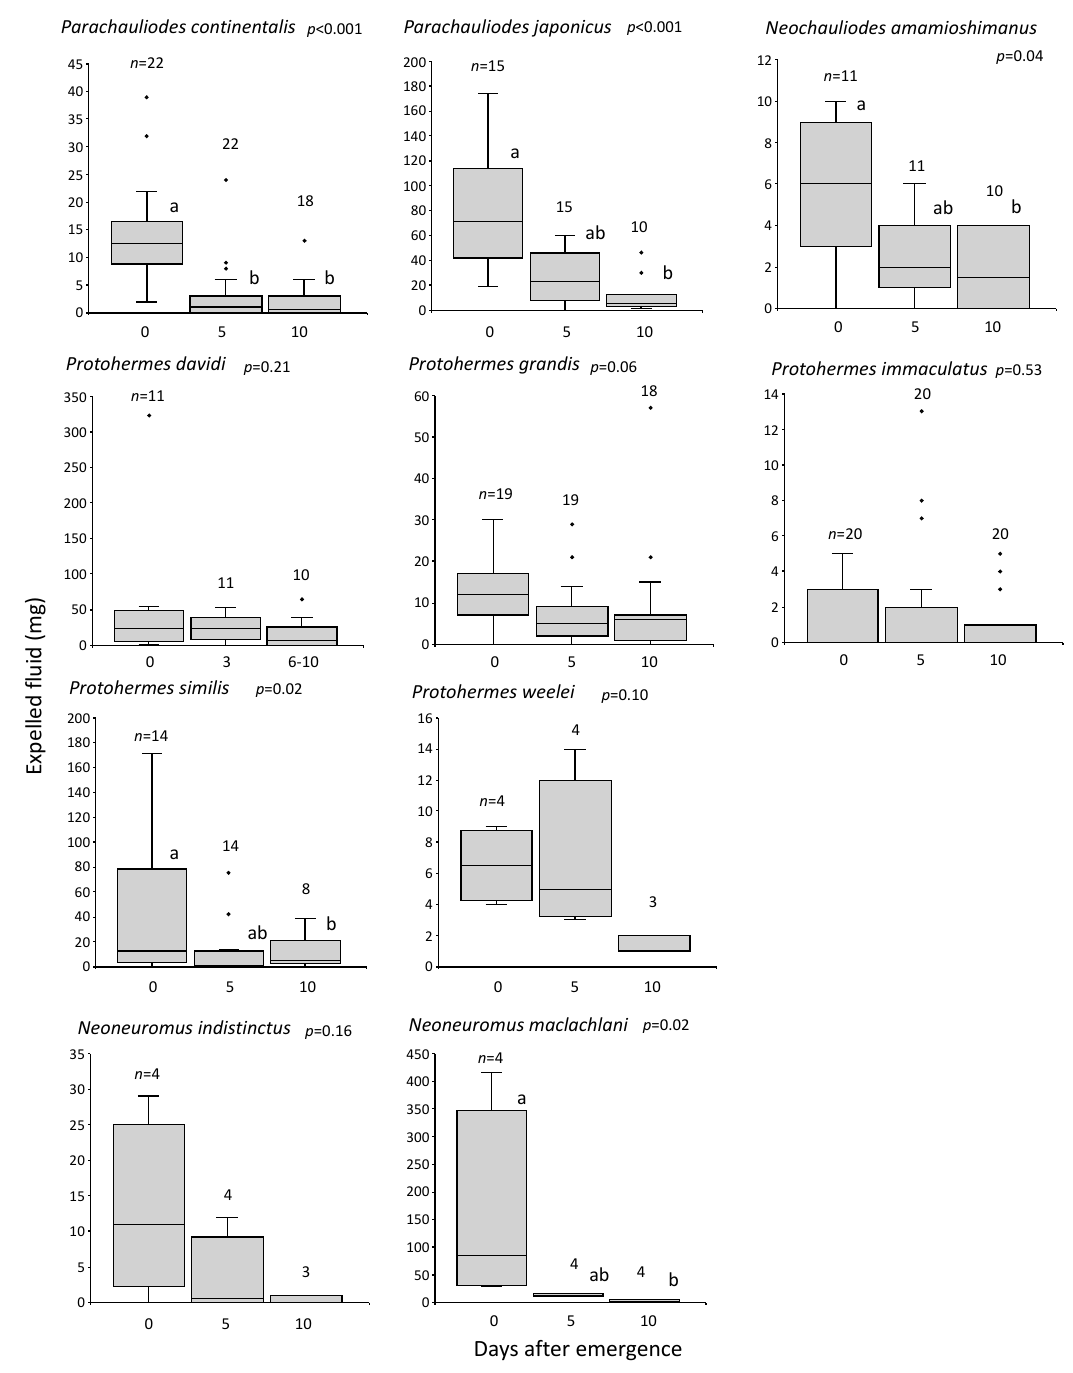
Figure 4. The amount of fluid expelled at 0, 5, and 10 days from emergence (but 0, 3, and 6–10 days in P. davidi ) in 10 species of fishflies ( Parachauliodes , Neochauliodes ) and dobsonflies ( Protohermes , Neoneuromus ). n : number of individuals examined, but some individuals died at the last examinations. Crosses are the mean values. p : the result of the Friedman test. Different alphabetic characters show significant differences ( p < 0.05) in the Dunn–Bonferroni post-hoc test in the species with statistically significant differences in the former test.